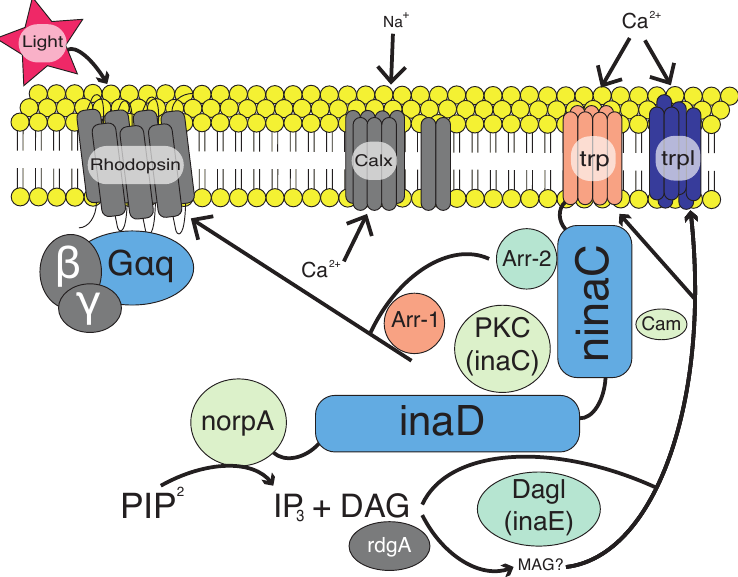
Figure 1. Diagram of the basic insect phototransduction pathway (modified from [6]). Components in gray represent parts of the pathway not sampled. Components in orange were sampled but were recovered in too few taxa for selection analysis. All other components are colored to reflect relative omega values as reported via the PAML analysis. Dark blue indicates high relative omega values whereas lighter blue/green indicates low relative omega